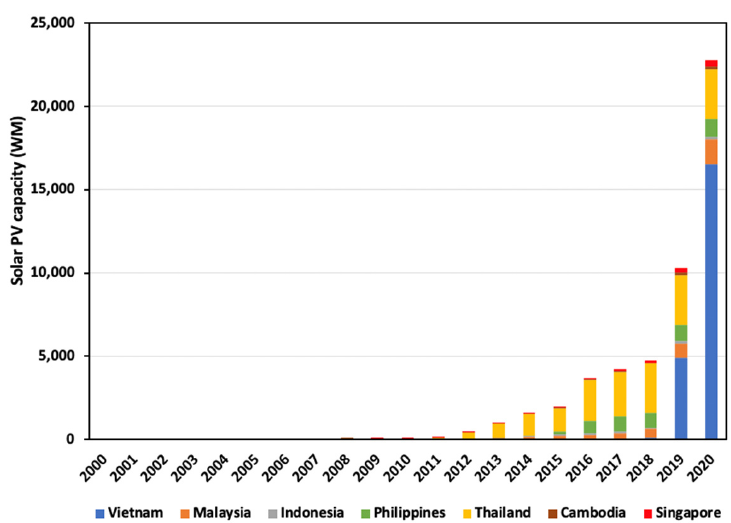
Figure 6. History of installed solar PV capacity in ASEAN [22] .